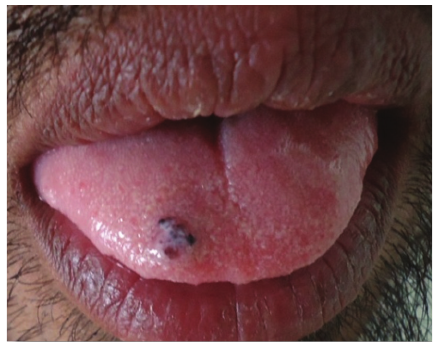
Figure 1: Brownish growth present on tip of tongue.